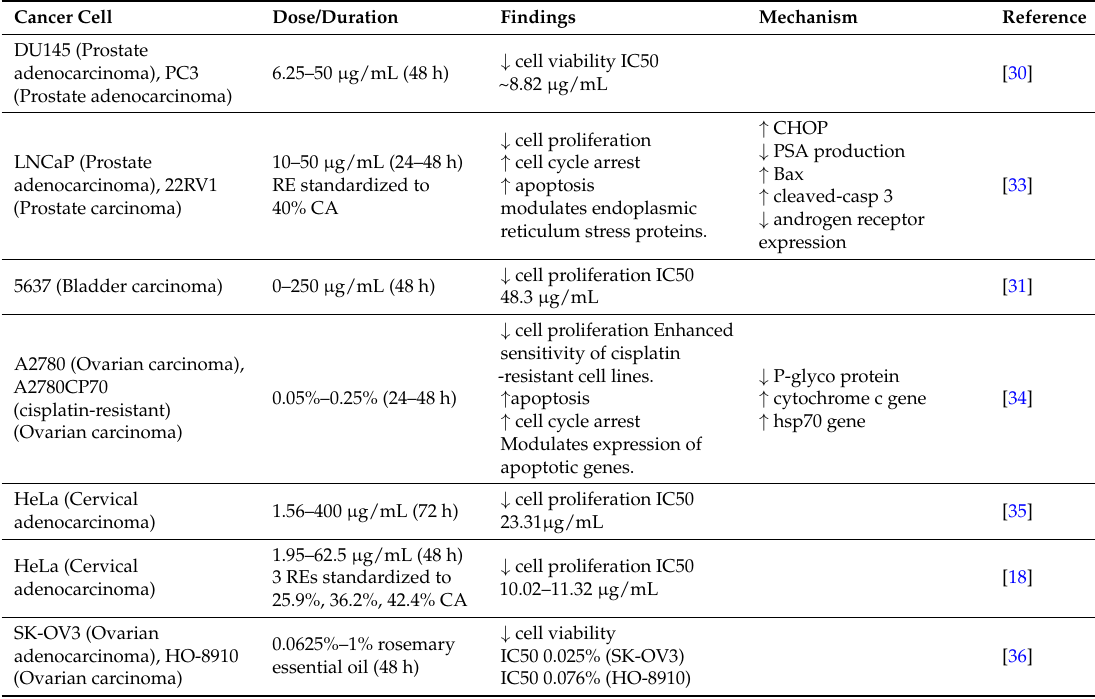
Table 3. Anticancer effects of Rosemary Extract (RE). In vitro studies: prostate, ovarian, cervical and bladder